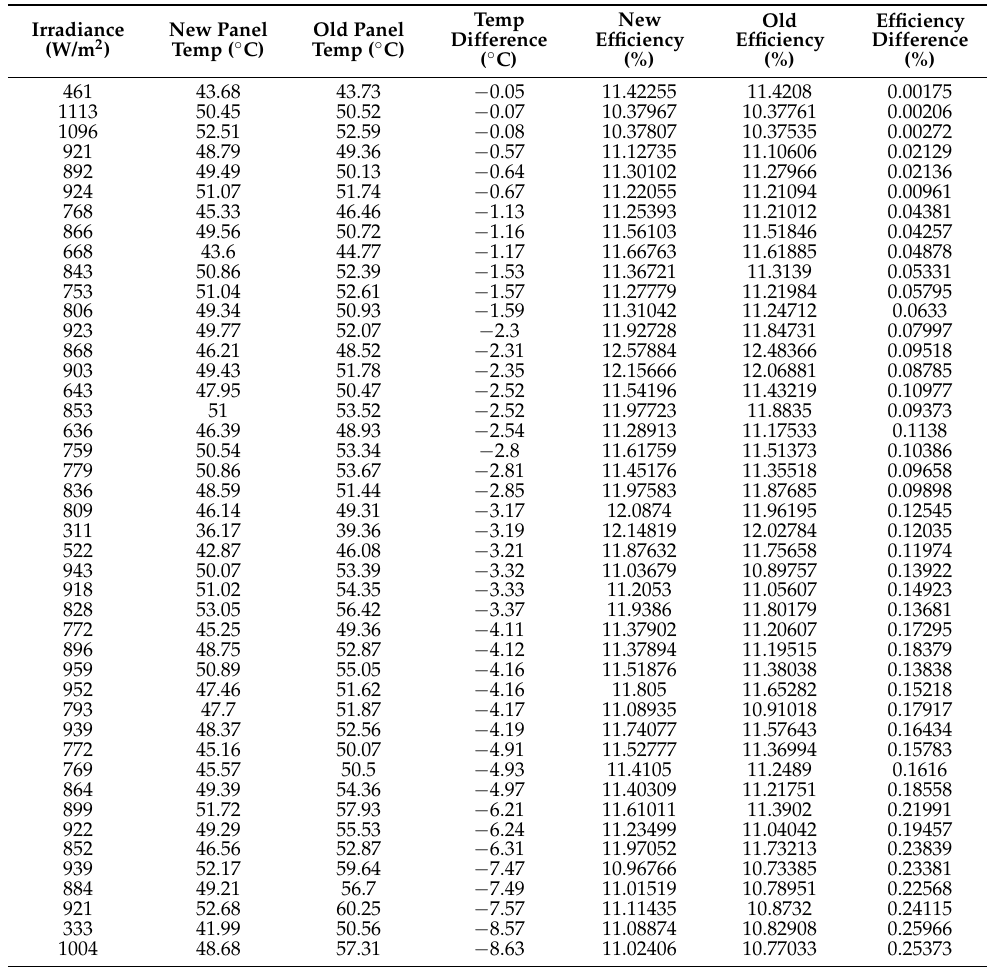
Table 6. Measured temperature–efficiency